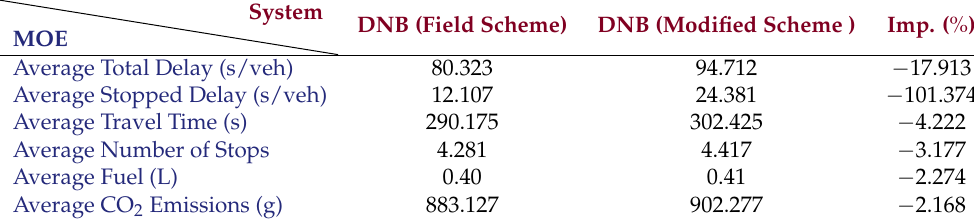
Figure 5. Four phasing scheme. ( a ) Implemented phasing scheme. ( b ) Suggested phasing scheme. Table 5. MOEs using two different phasing